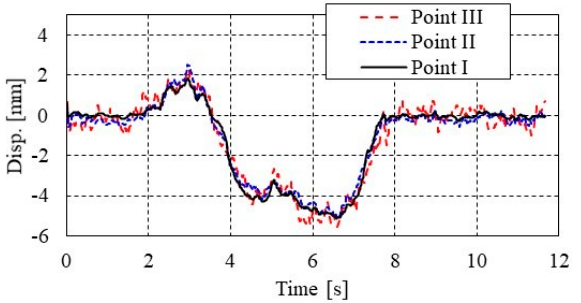
Figure 25. The effect of smoothing on the non-marker image measurement error (bridge B).